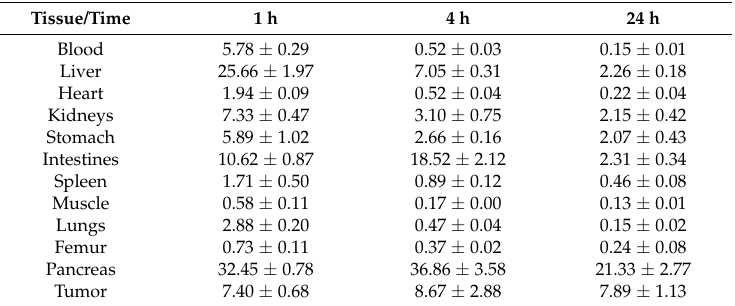
Table 2. [ 67 Ga]NeoBOMB1 biodistribution data, as % ID/g mean ± sd, n = 4; at 1, 4 and 24 h pi in T-47D Xenograft-Bearing SCID Mice at a 200 pmol peptide dose 1